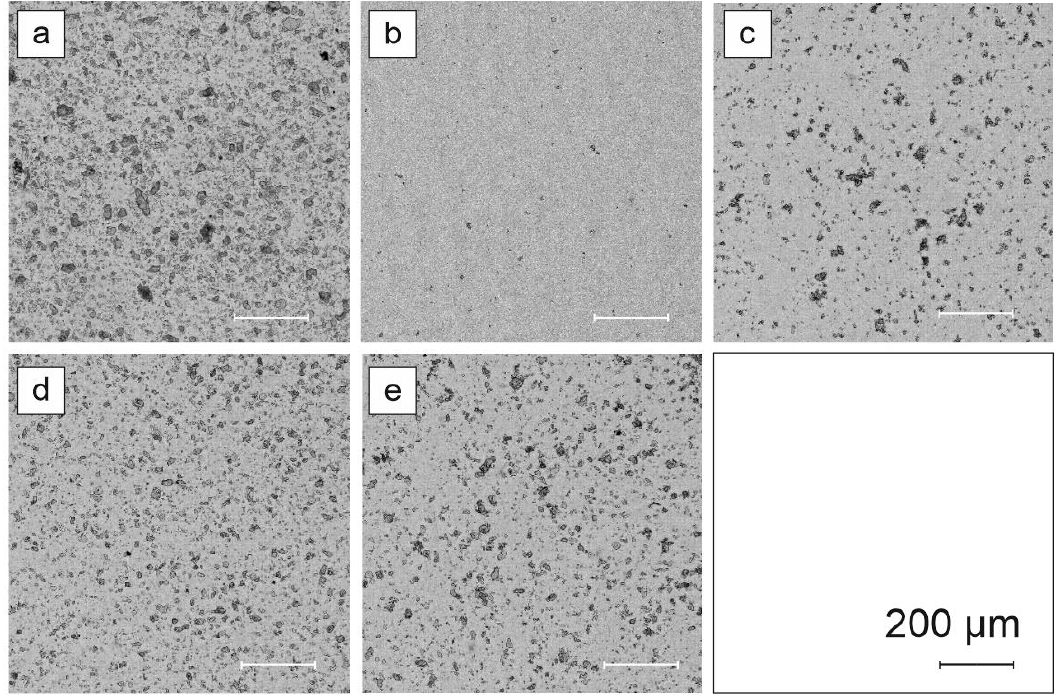
5 of 11 Figure 2. Egyptian blue photoluminescent imaging: ( a ) relation between camera detection spectrum and Egyptian blue emission spectrum (based on Semiconductor Components Industries KAF−16803/D datasheet [21] and Errington [1]), ( b ) measurement system for photoluminescence imaging. In order to stop the excitation wavelength, an IR bandpass filter was selected. The excitation source was a 65 W electrical power 808 nm laser. In the photoluminescence ef- fect verification, each sample contained the same amount of Egyptian blue.